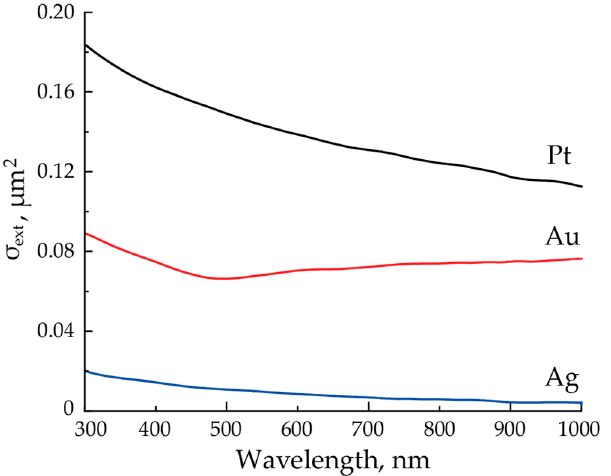
Figure 4. Extinction cross-section spectra of a single NP averaged over the flow of initial agglomerates for Pt, Au and Ag.